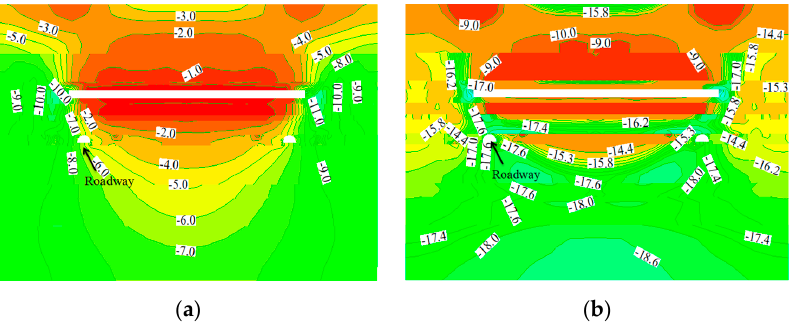
Figure 14. Stress distribution characteristics of floor stress after coal seam 15# mining: ( a ) Minimum principal stress (MPa); ( b ) Maximum principal stress (MPa).